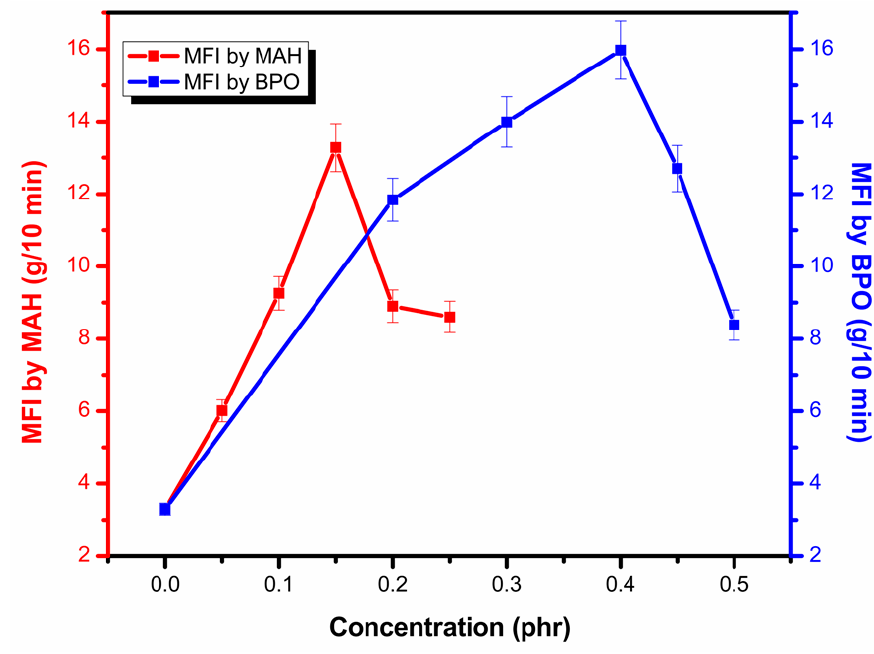
Figure 8. Melt flow index of functionalized samples by varying MAH and BPO.